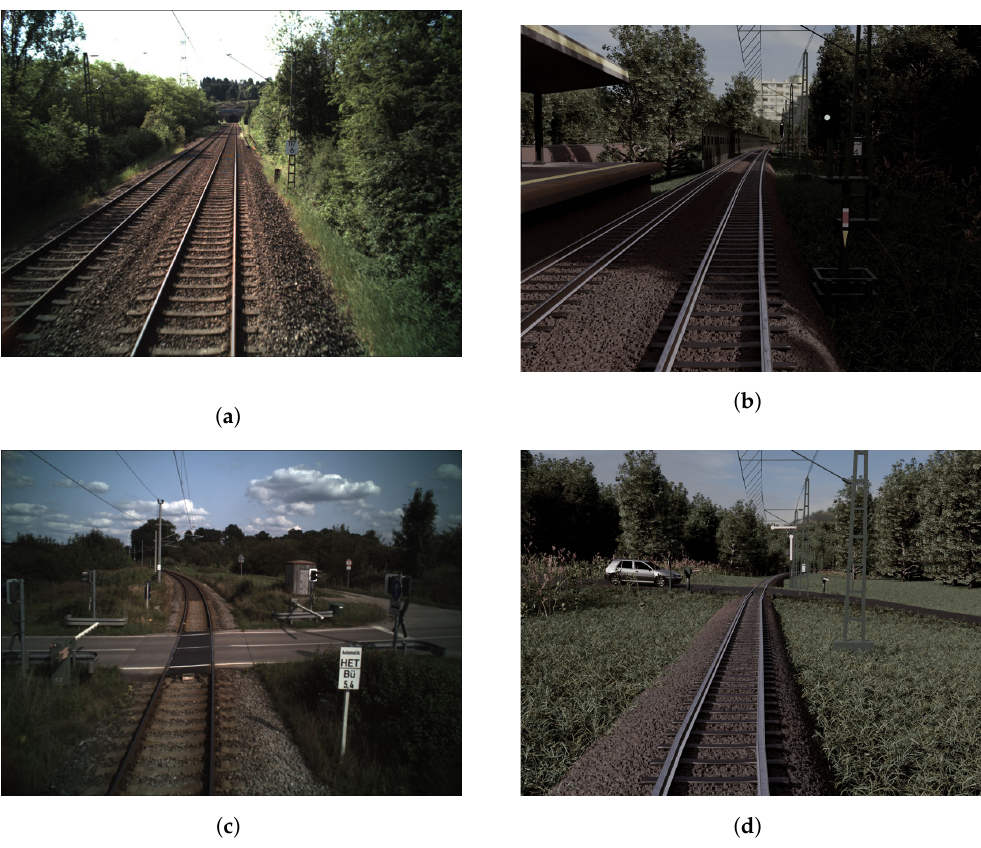
Figure 3. Real ( a , c ) and synthetic ( b , d ) data samples.